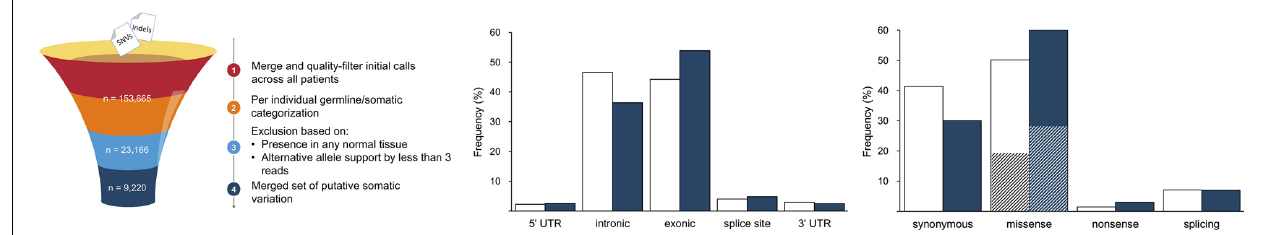
FIGURE 1 | Summary of major variant call filtering steps (left panel) and annotation results identified in gene elements (middle panel) and of coding consequences (right panel; deleteriousness shown as striped sections). The reference dataset of germline variation is shown in white and the somatic variation is represented in blue.